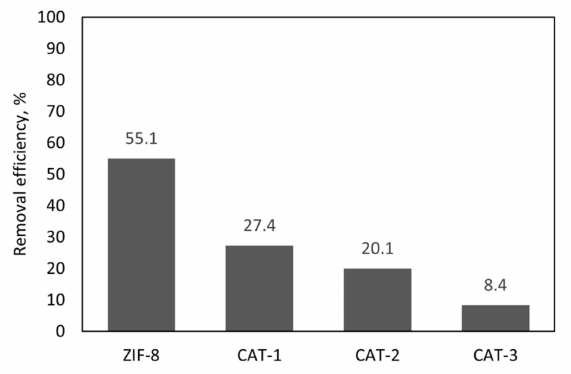
Figure 9. Comparison of the imidacloprid removal efficiency on different